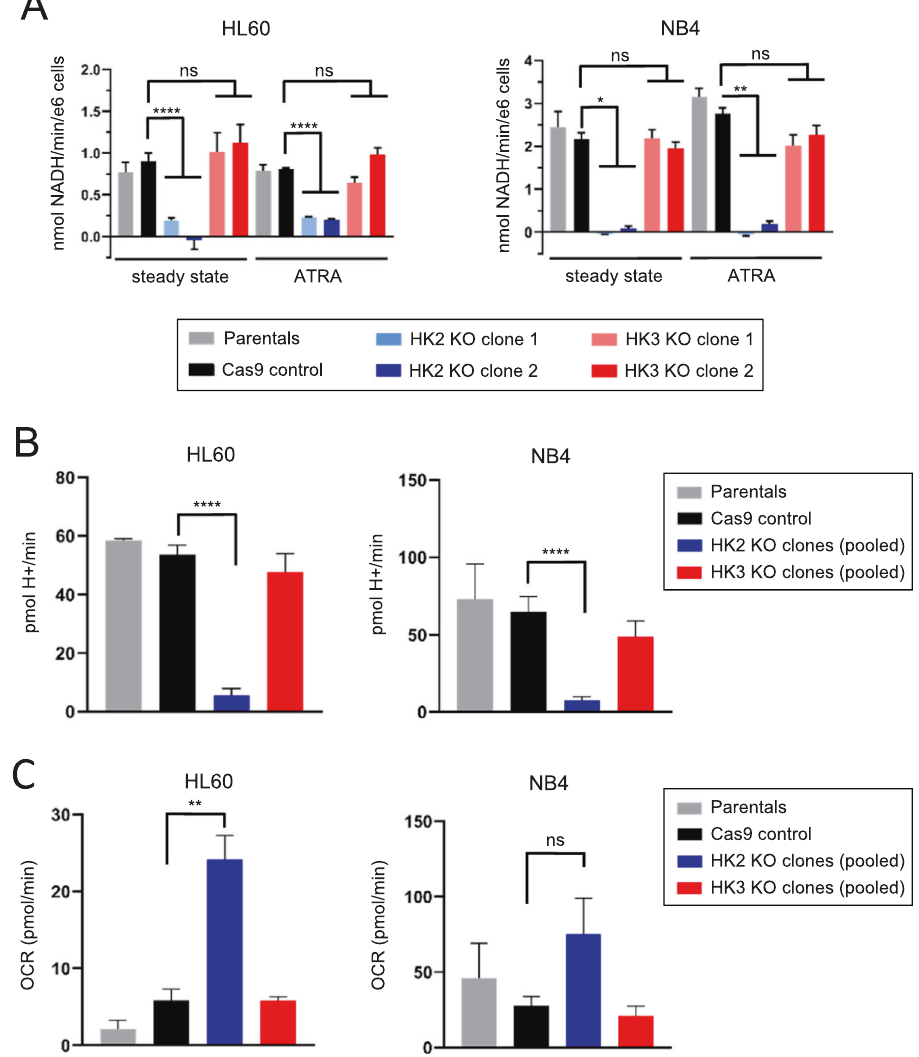
Fig. 2 HK3 is dispensable for glucose-6-phosphate generation and glycolysis. A Hexokinase activity assay measuring G-6-P generation in HL60 and NB4 cell line panels at steady state and after 3 days of ATRA treatment ( n = 3, 2 technical replicates each, mean ± SEM). B , C Seahorse analysis of HK2 and HK3 KO in HL60 and NB4 cells. Glycolytic rate assay ( B ) and mitochondrial stress test ( C ) measuring extracellular acidi fi cation rate as a function of glycolytic activity and oxygen consumption as a function of mitochondrial respiration, respectively ( n = 3, 4 technical replicates each, mean ± SEM). Mann – Whitney U : * p < 0.05, ** p < 0.01, **** p <